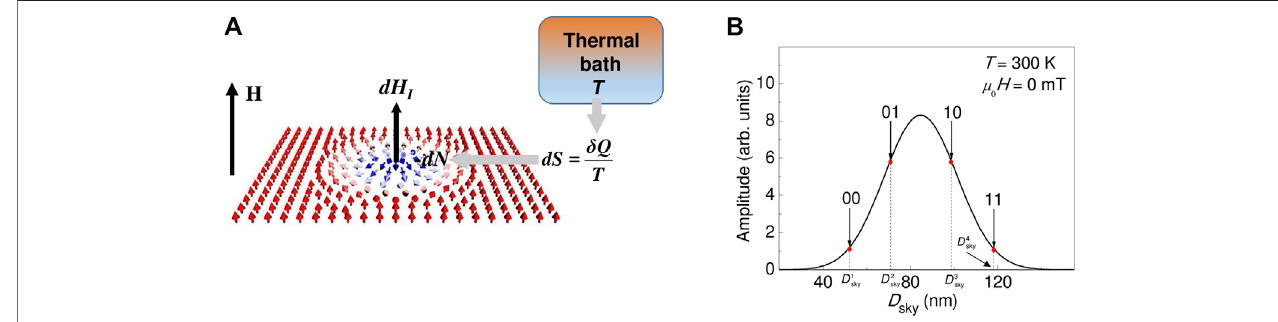
FIGURE 2 | (A) Sketch of the ferromagnetic nanostructure ( fi lm) hosting a Néel magnetic skyrmion (outwardly magnetized and negative p = − 1) regarded as a closed thermodynamic system. The in fi nitesimal reversible exchange of entropy dS ( δ Q is the in fi nitesimal absorbed heat) between the thermal bath and the fi lm at temperature T and between the fi lm and the skyrmion is indicated. dN is the in fi nitesimal skyrmion negentropy, and dH l is the in fi nitesimal information entropy. (B) The sampling of the skyrmions ’ diameter distribution at T = 300 K and μ 0 H (cid:2) 0mT via the assignment of the 4-bit con fi gurations 00, 01, 10, and 11 to the skyrmion diameters, D sky1 , D sky2 , D sky3 , and D sky4 , respectively. For the parameters used [6], H l ≈ 2 bits and the number of bit con fi gurations is